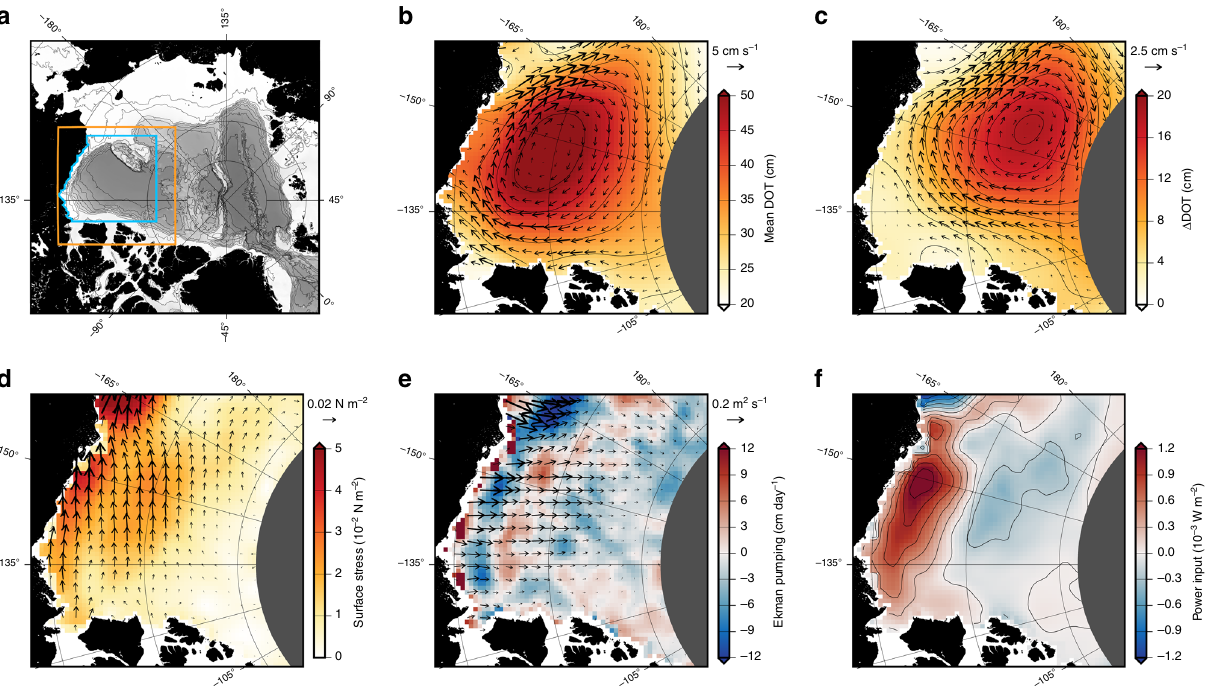
Fig. 1 State of the Beaufort Gyre 2003 – 2014. a A map of the Arctic Ocean showing the Western Arctic region plotted in b – f (orange line), the Beaufort Gyre region over which area averages are computed (blue line) and 500 m isobaths taken from Amante and Eakins 44 (black lines). b The 2003 – 2012 mean dynamic ocean topography (shading; contours are drawn every 5 cm) and surface geostrophic currents (cm s − 1 ; vectors). c The change in dynamic ocean topography (shading; vectors drawn every 2 cm) and geostrophic currents (cm s − 1 ; vectors) between 2003 – 2006 and 2008 – 2014, d the 2003 – 2014 mean ocean surface stress (N m − 2 ; vector and shading), e the 2003 – 2014 mean Ekman pumping velocity (shading) and Ekman layer velocity (m 2 s − 1 ; vectors), and f the 2003 – 2014 mean wind power